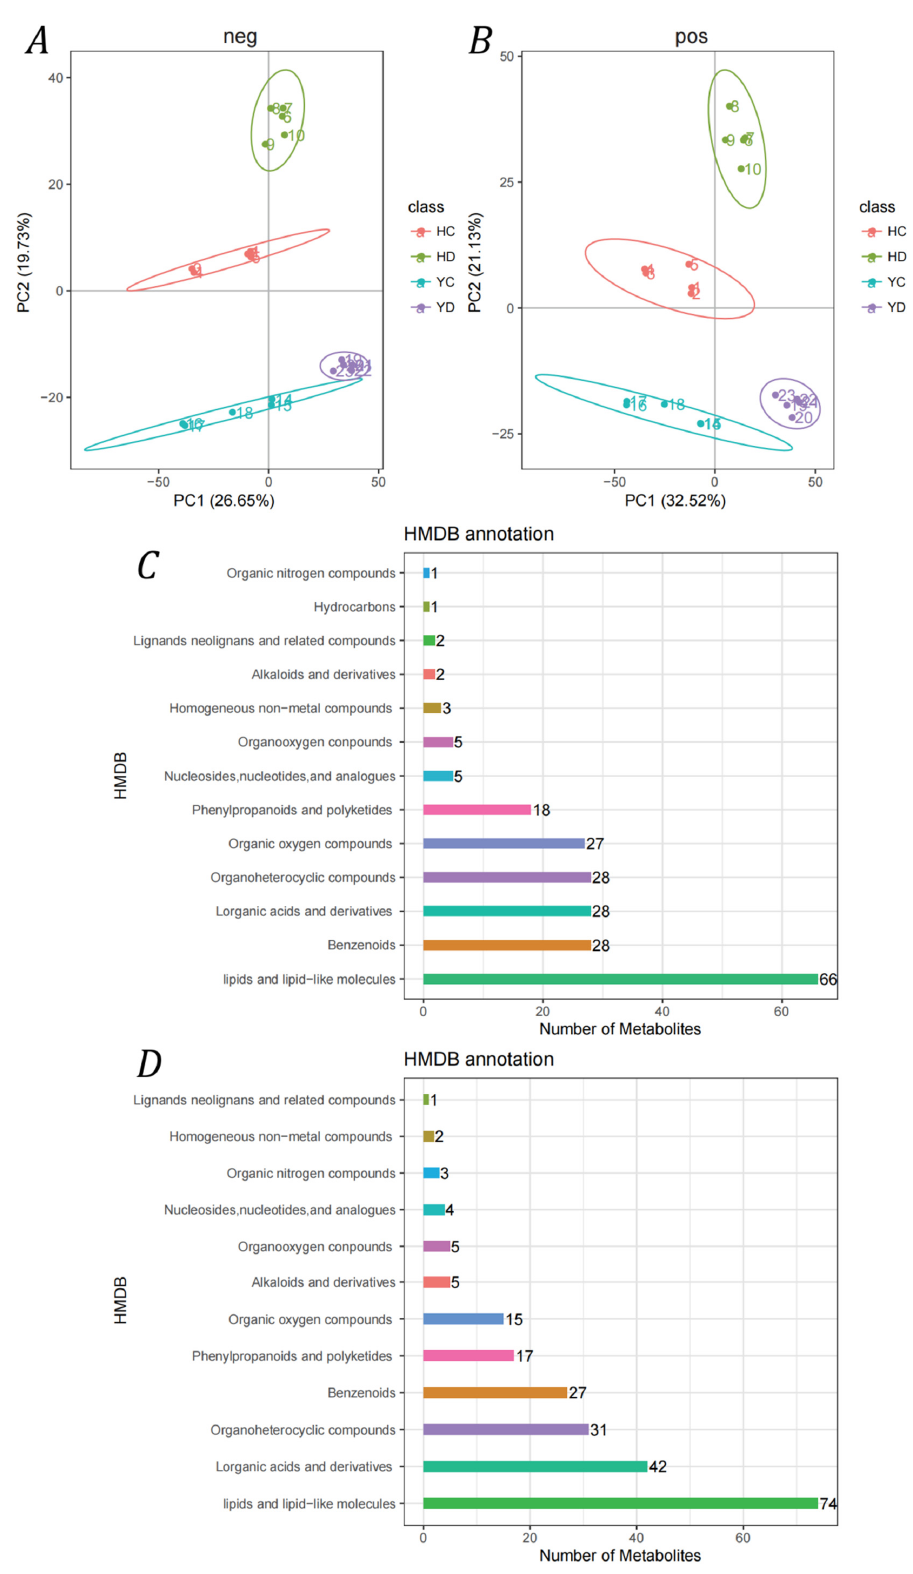
Figure 6. PCA of quantitative metabolite data and HMDB annotation of metabolites. ( A , B ): PCA of metabolites in positive ion mode and negative ion mode. ( C , D ): HMDB database annotations for metabolites in positive ion mode and negative ion